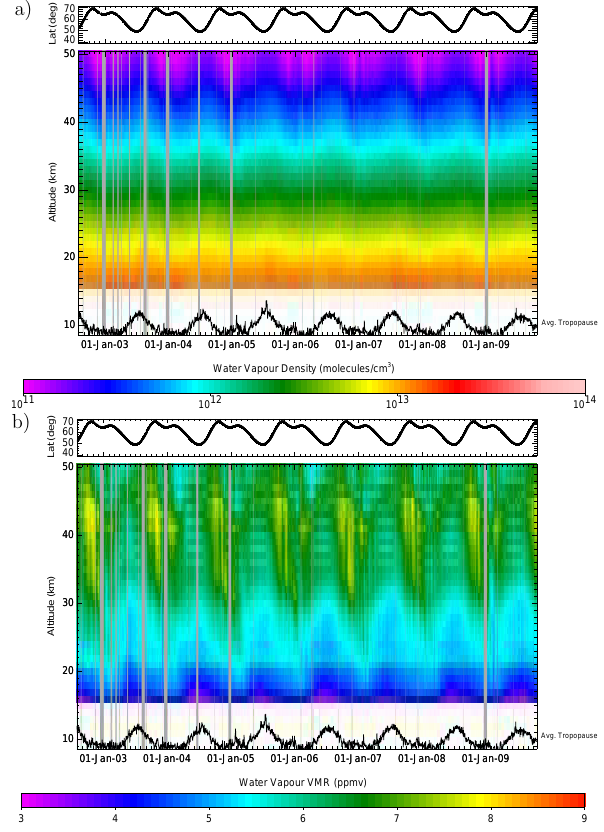
Fig. 6. Daily averaged water vapour profiles derived from SCIA- MACHY occultation measurements with the Onion Peeling DOAS method. (a) Number density profiles. The latitudinal range of the SCIAMACHY measurements is indicated on top of the figures. The black curve shows the average tropopause height, derived from col- located ECMWF data. Periods of reduced SCIAMACHY data qual- ity (due to instrument switch-offs or decontamination periods) have been masked out (vertical grey bars). (b) Same plot for volume mixing ratio (VMR)